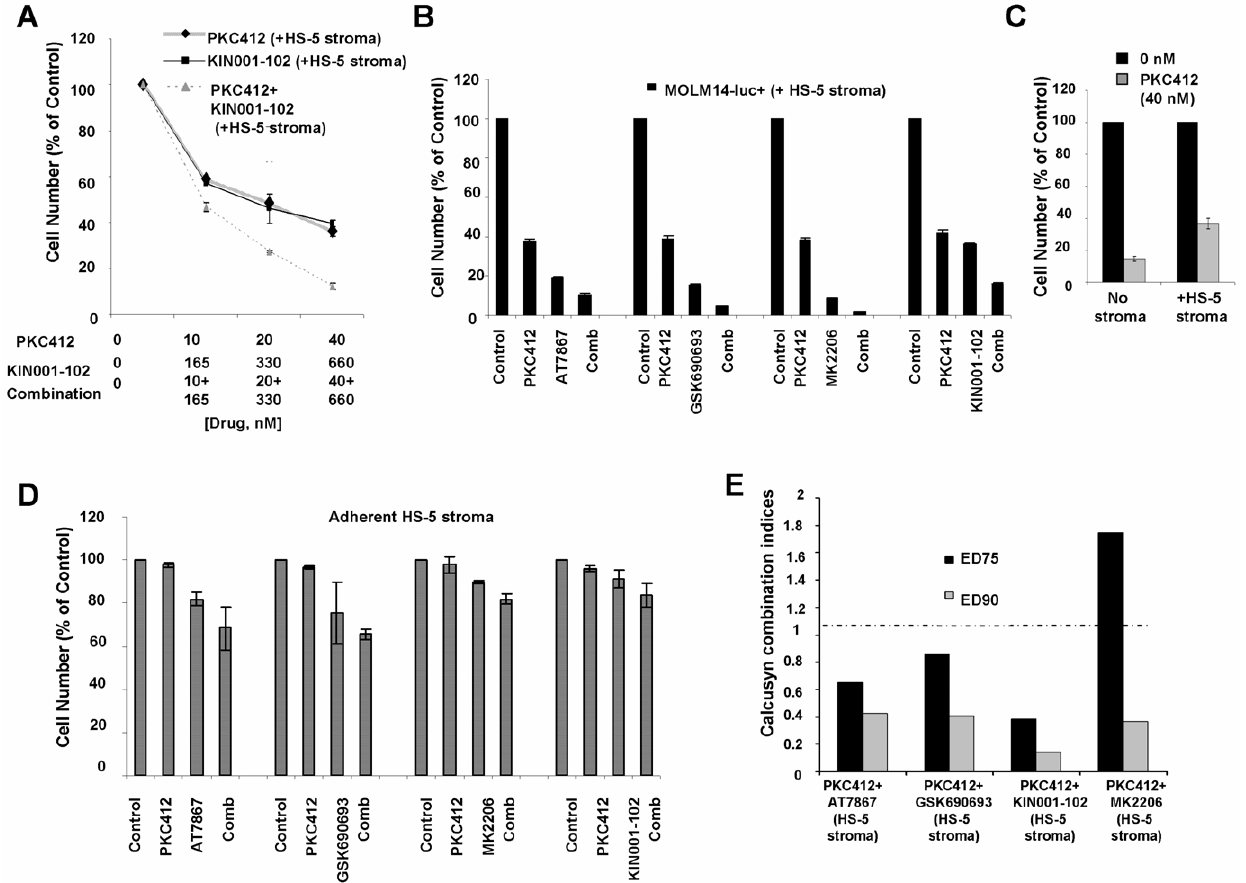
Figure 1. Selective inhibitors of AKT positively combine with PKC412 in the presence of adherent HS-5 stroma against MOLM14- luc + cells. (A) Approximately two-day proliferation study performed with MOLM14-luc + cells cultured in the presence of adherent HS-5 stroma testing the combination of PKC412 and KIN001-102 versus each agent alone. (B) MOLM14-luc + cells cultured in the presence of adherent HS-5 stroma for approximately two days: PKC412 (40 nM) + / 2 Akt inhibitors (660 nM). (C) Approximately two-day PKC412 treatment of MOLM14-luc + cells cultured in the absence and presence of human stroma. (D) Approximately two-day treatment of adherent HS-5 stroma: PKC412 (40 nM) + / 2 Akt inhibitors (660 nM). (E) Calcusyn combination indices derived from 4-point concentration proliferation experiments. The cut-off for nearly additive effects (C.I.: 1.1) is marked by a dashed line.